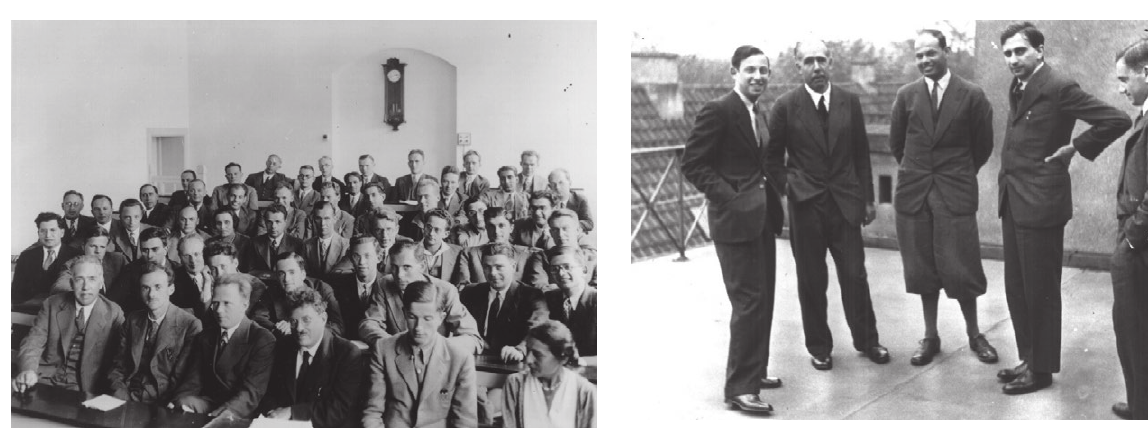
Figure 2. Conference at Bohr’s institute, September 1933. On the first row: N. Bohr, P. Dirac, W. Heisenberg, P. Ehrenfest, M. Del- brück, L. Meitner. Milton Plesset is on the second row, number four from the right, and Christian Møller seats behind him, number three from the right on the third row. Credit: Niels Bohr Archive, Photo Collection, Copenhagen.